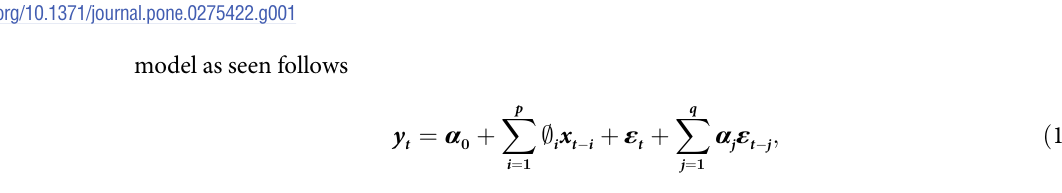
Fig 1. a-g. The real unemployment rate in selected Asian countries is graphically